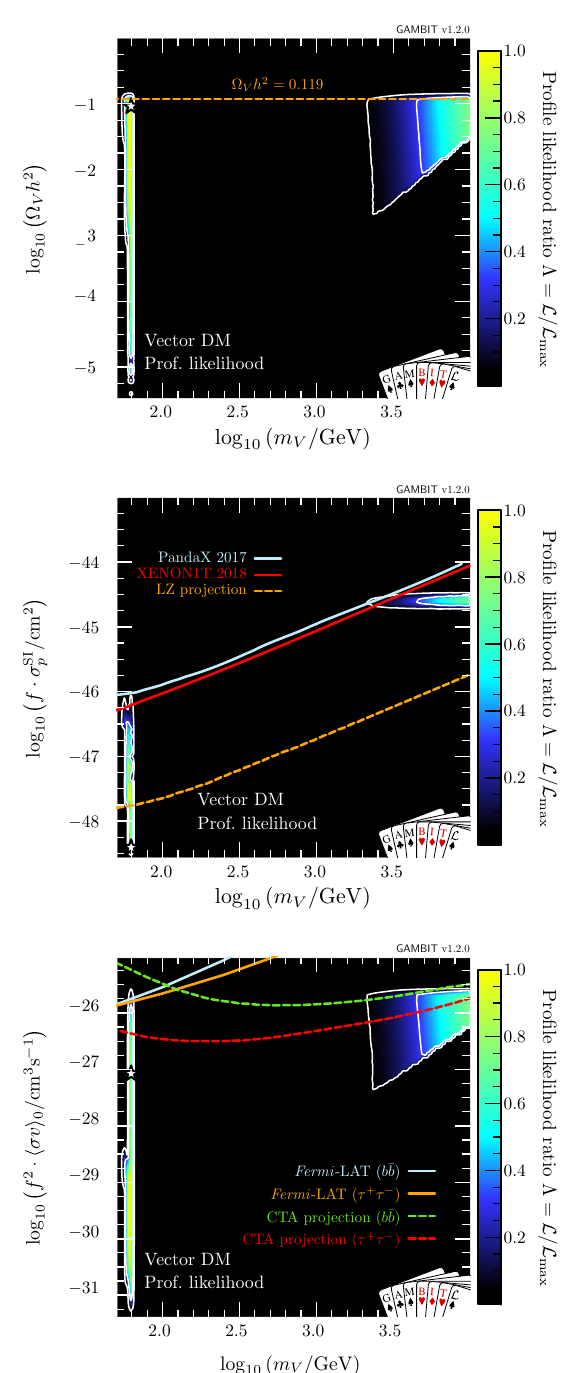
Fig. 2 Profile likelihoods for vector DM in planes of observable quan- tities. Top: relic density. Centre: spin-independent WIMP-proton cross- section, where solid lines show exclusions from PandaX 2017 [88] and XENON1T 2018 [89], and the dashed line shows the expected sensi- tivity of LZ [138]. Bottom: present-day DM annihilation cross-section, where solid lines show published exclusions from Fermi -LAT [85], and dashed lines show projections from CTA [139] (see footnote 10 for more details). Contour lines in each panel show the 1 and 2 σ confidence regions, while the white star shows the best-fit point. Cross-sections are rescaled by the fraction of predicted relic abundance f ≡ (cid:14) V /(cid:14)